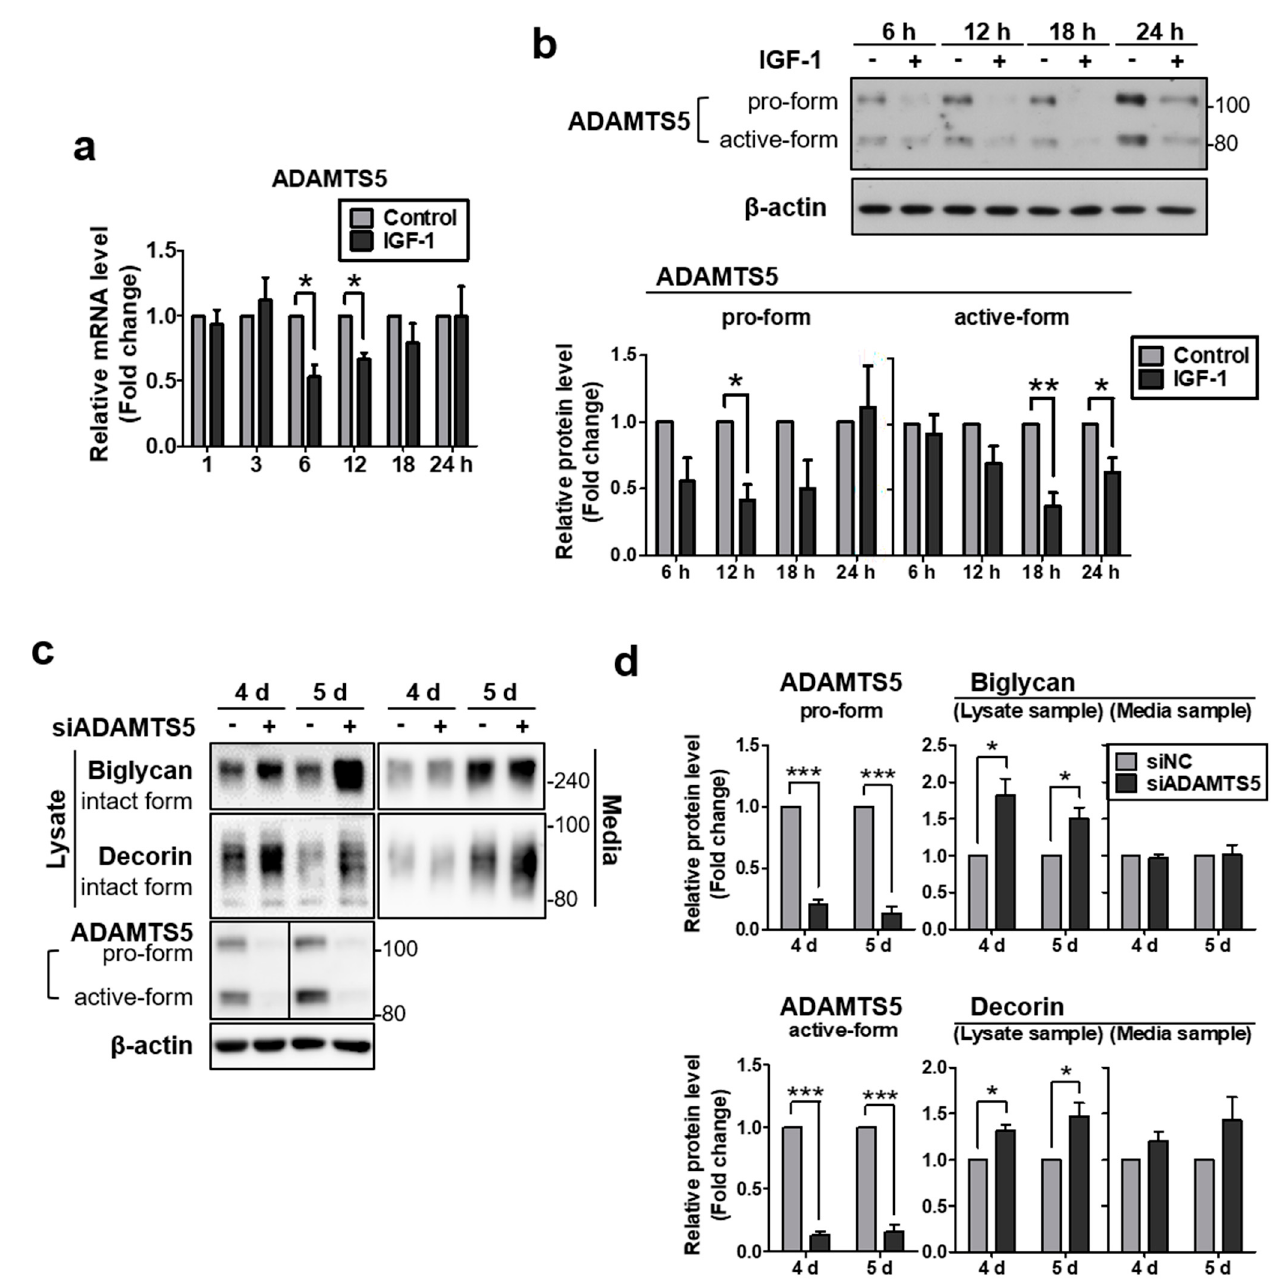
Figure 3. IGF-1 downregulated the expression of ADAMTS5, and knockdown of ADAMTS5 resulted in augmented biglycan and decorin protein levels in NHDFs. Total RNA was extracted and the expression of ( a ) ADAMTS5 mRNA was subsequently measured by quantitative real-time PCR and normalized to the expression of 36B4. ( b ) Protein levels of ADAMTS5 were measured by western blotting. ( c ) Primary NHDFs were treated with ADAMTS5 siRNA and harvested at indicated times after treatment. Proteins of conditioned media and cell lysates were analyzed by western blotting. ( d ) Relative protein amounts were analyzed using ImageJ. Band intensity was normalized to that of β -actin. Values represent the mean ± SEM of data ( N = 4). Statistical comparison was made using paired t -test. (* p < 0.05, ** p < 0.01, *** p < 0.001).